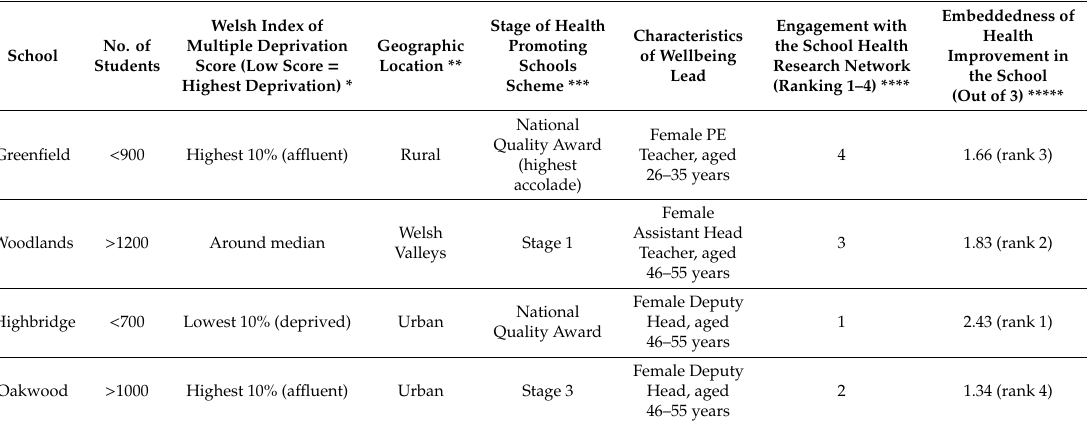
Table 2. Case study